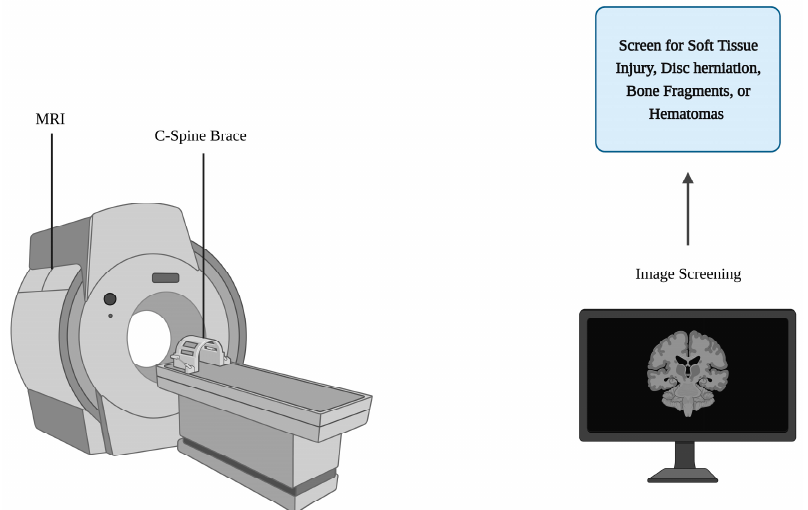
Figure 1. Illustration of MRI machine with cervical spine brace used to screen for soft tissue injuries. Image made with Biorender.com, accessed on 15 November 2022.